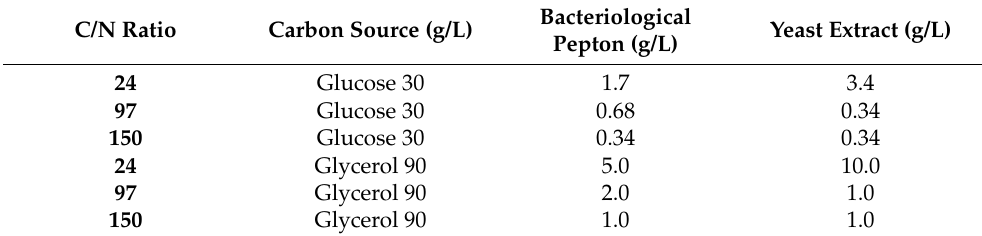
Table 1. Composition of carbon and nitrogen source at different C/N ratios.